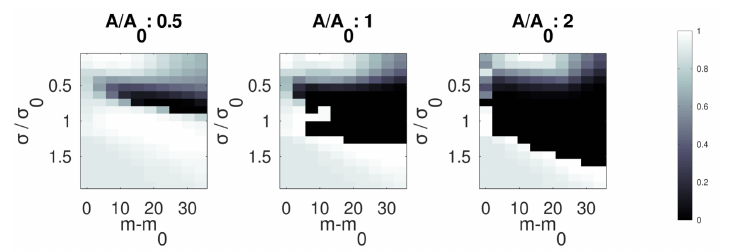
Figure 8. Performances of the classifier when a spurious peak is overlapped in the fitting region to the true one. The color refers to the k-score expressing the overall belonging of the peak. Calculations have been performed after synthetic noise was added to the peak for an SNR of